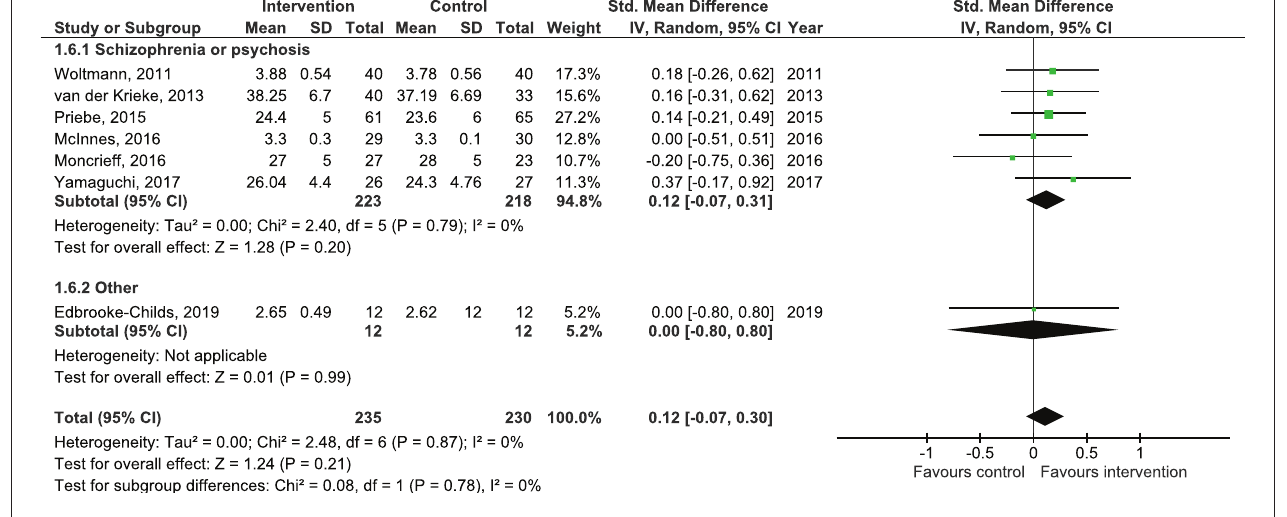
FIGURE 8 | Forest plot for patient satisfaction by diagnosis.